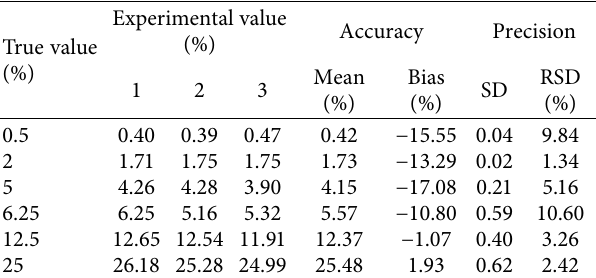
Table 5: Unknown sample analyses for GMO content (%) using the pGMT27 plasmid as the calibrator (Cf �